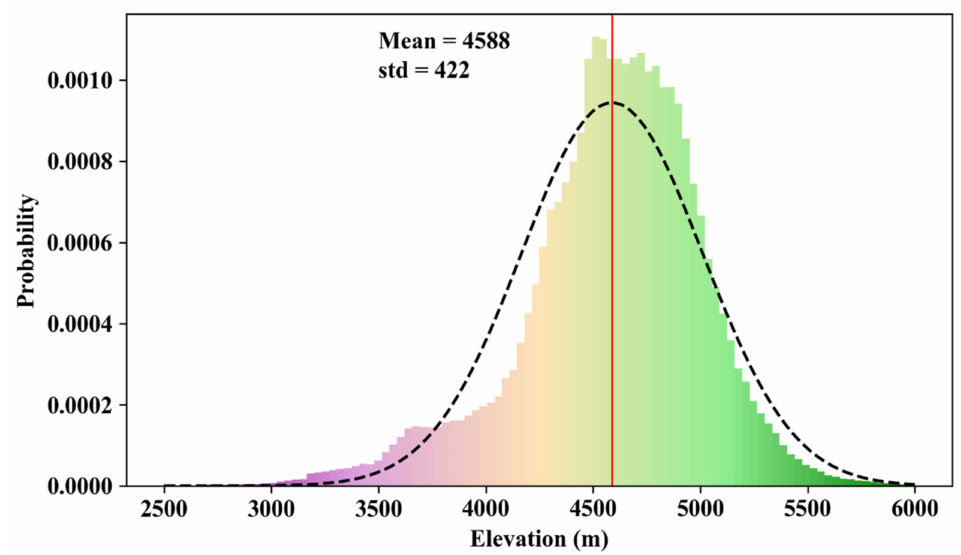
Figure A4. Distribution of the probability density of DEM (Digital Elevation Model) in TRSR. The histogram indicates the probability of DEM pixel distribution. The dashed line denotes the probability density function, assuming they are Gaussian distributed. The red line denotes the mean value of